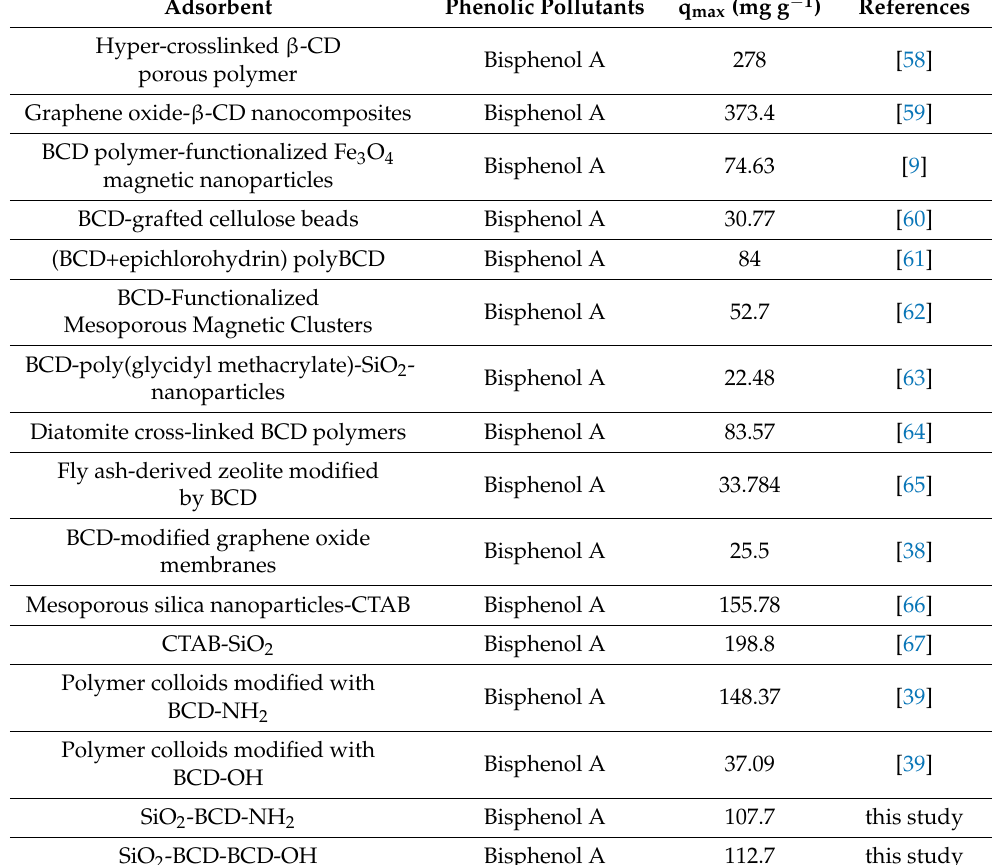
Table 3. Comparison of adsorption capacities of different adsorbents for bisphenol